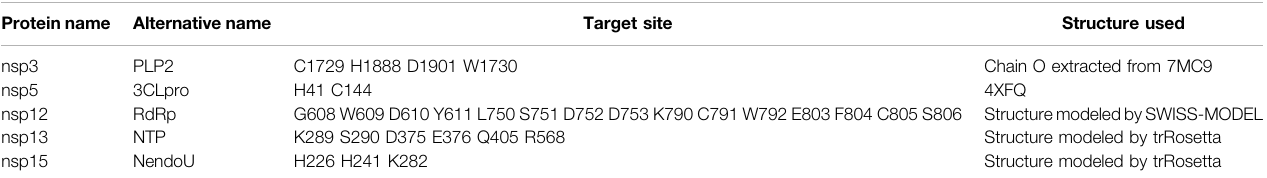
TABLE 2 | Summary of selected replicative enzymes and 3D